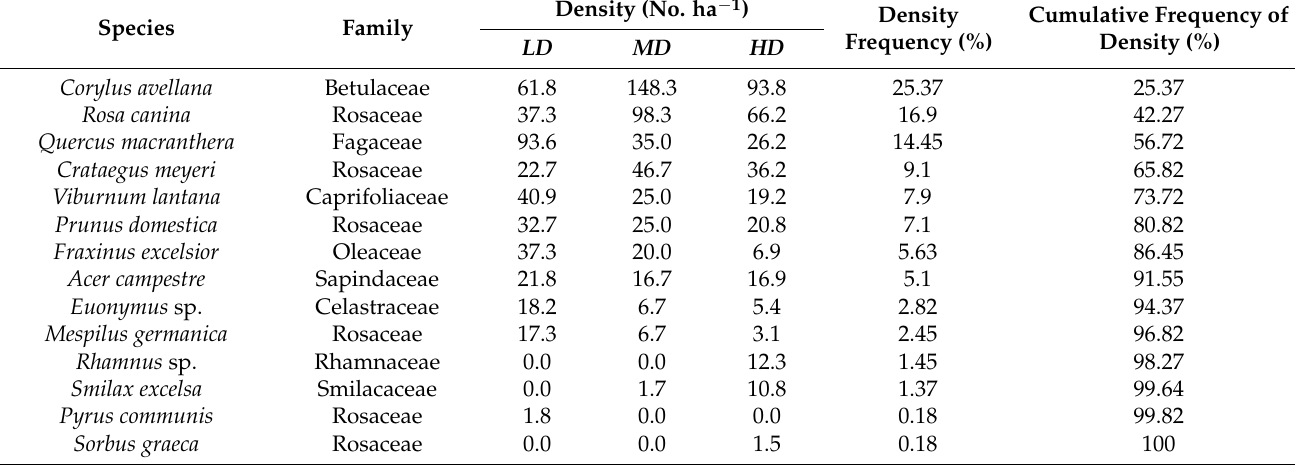
Table 7. The density of regenerating woody trees (DBH < 5.0 cm and height < 1.5 m) by species, destruction class, and total and cumulative frequency in a naturally-regenerated broadleaf forest in the Arasbaran biosphere reserve in Iran ( n = 30). LD = Low Destruction, MD = Medium Destruction, and HD = High Destruction. See Table 2 for the destruction class description. Cumulative is the summation of the density frequency